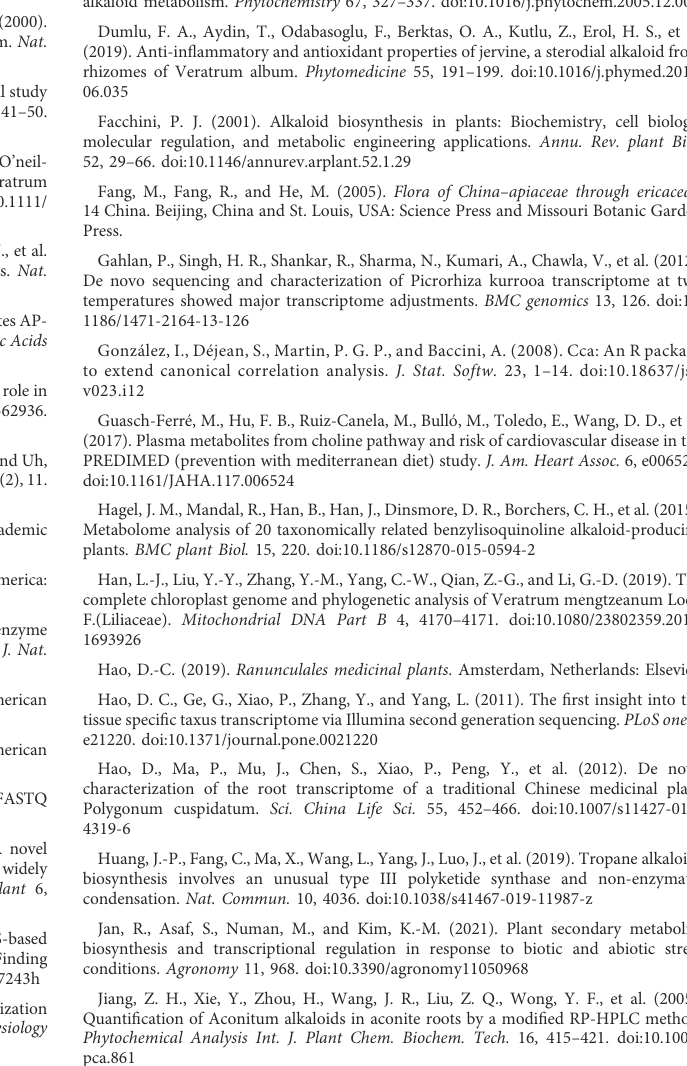
content, green: represents lower content). The annotation bar above the heat map corresponds to the sample grouping (leaves and roots); the note bar on the left side of the heat map corresponds to the Class of substance (alkaloids here). The correlation coef fi cients were used as a clustering algorithm to classify features determined by Pearson correlation based on average/means. The color gradient from orange (1.5) to green ( − 1.5) depicts several compounds, presented as relative fold